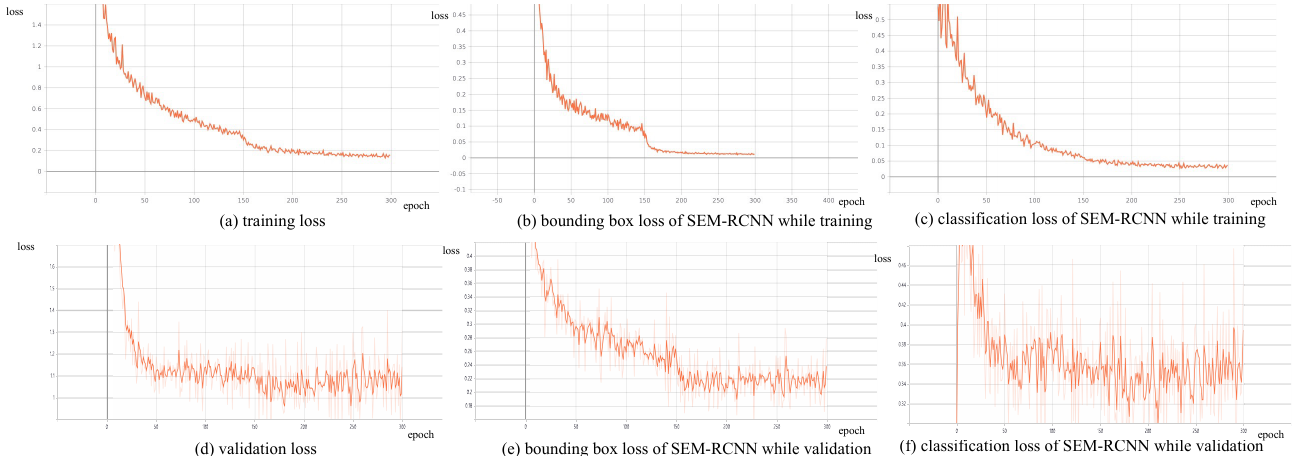
Figure 13. The loss curves of SEM-RCNN while training and validation on